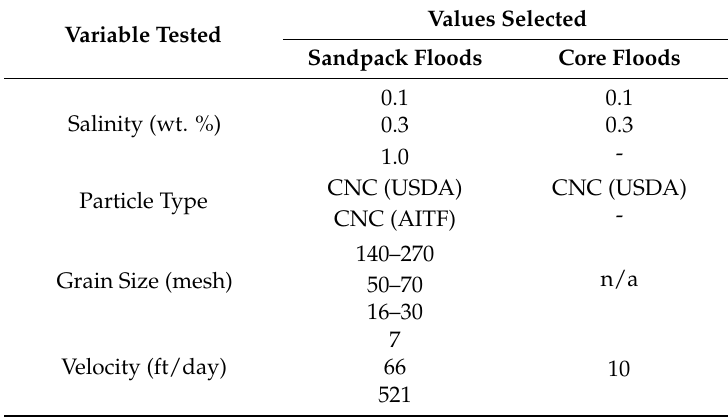
Table 3. Variables tested and values selected in retention flooding